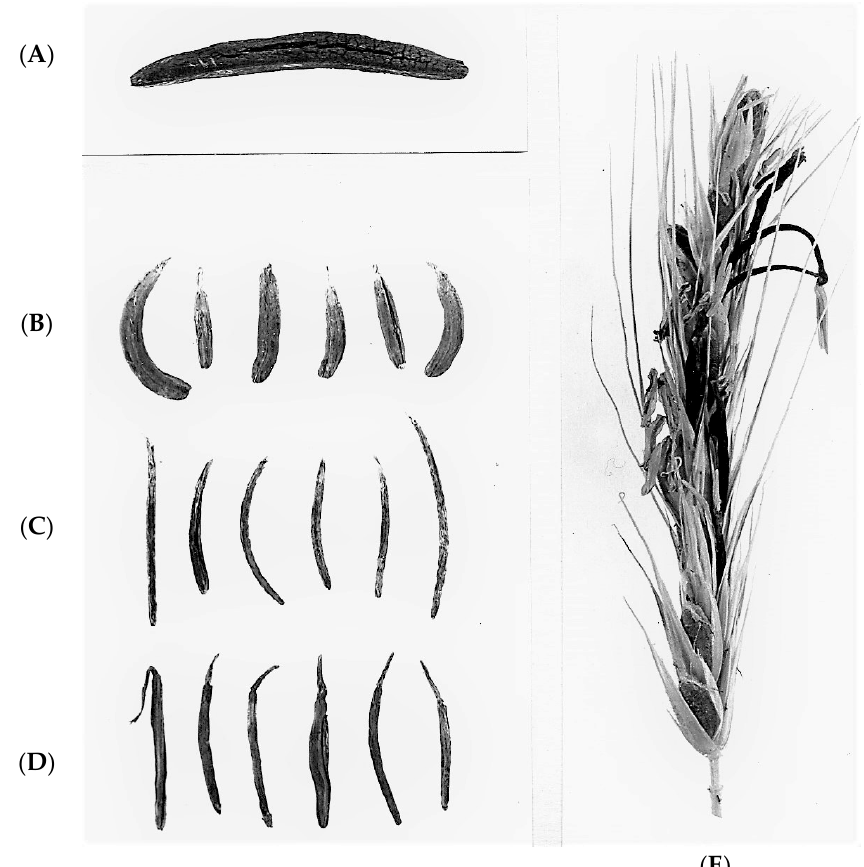
Figure 1. Variations in morphology of ergot sclerotia from different hosts in descending order ( A – D ); ( A ), Fourex rye; ( B ), Triticale; ( C ), Petkus rye; ( D ), Winter rye (Scheme 1; Table 1). Sphacelial honeydew exudation was normal early in parasitism, and similar alkaloid composition occurred, in sclerotia of ( A – C ). Sclerotia in ( C ) are exceptionally thin, as similarly in ( D ) which had developed in the apparent absence of honeydew and had low alkaloid content. ( D ) sclerotia have anthers retained; plants grown in glasshouse. ( E ); Re-isolate from a thin sclerotium on winter rye ( D ) and inoculated again into winter rye. Developed also in the absence of sphacelial honeydew, and similarly yielded exceptionally thin sclerotia, some of which seem to have split early in development. This resulted in pairs of ergots in florets, free at the base but sometimes fused at the top, and confirmed the exceptionally thin sclerotial morphology. Anthers were retained on sclerotia, since plants were glasshouse grown.